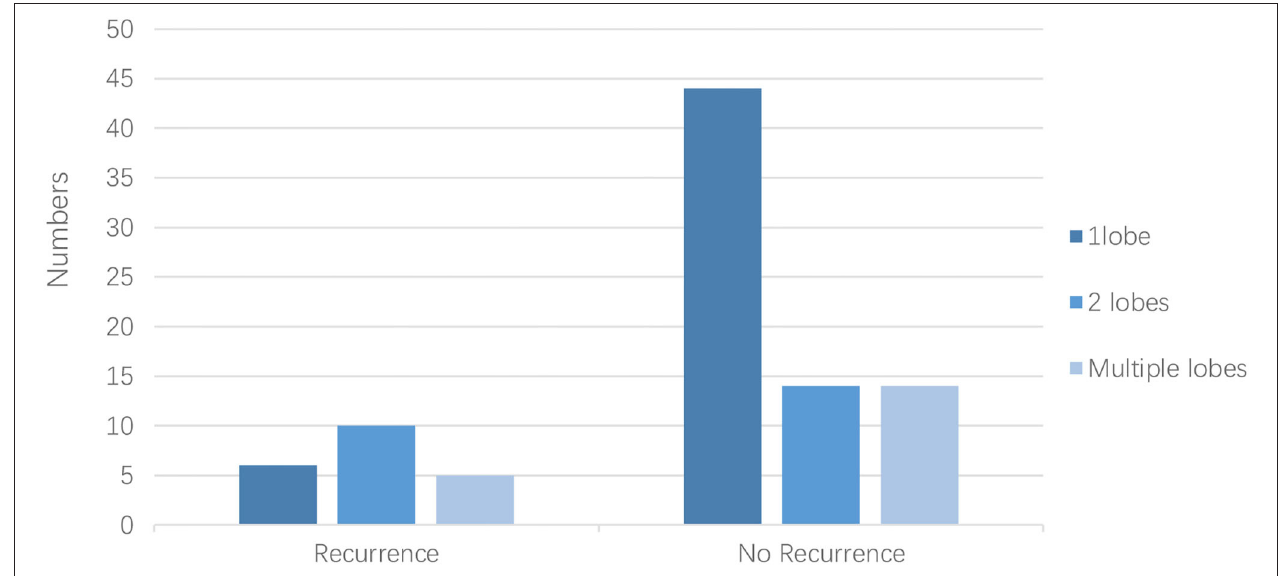
FIGURE 3 | LAA structure (lobes) with AF recurrence.